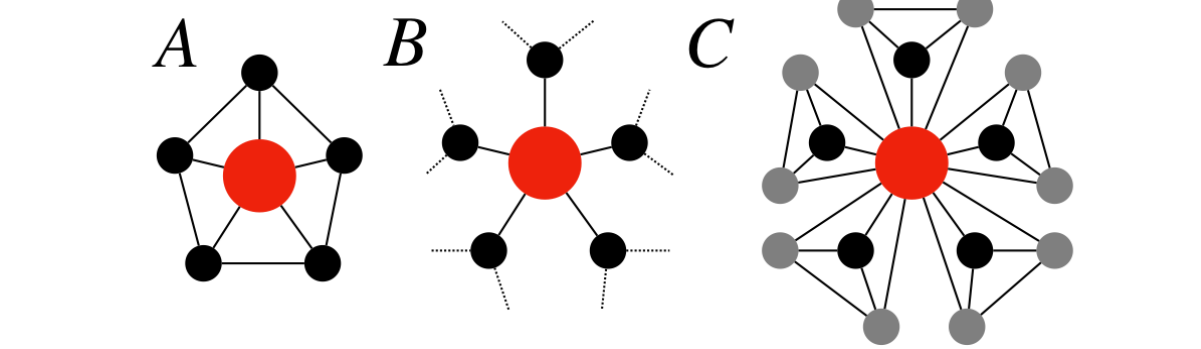
Figure 1. Three network structures associated with three distinct forms of social medical capital. The nodes represent the users, and each link refers to communication between users. The type of benefits that a focal user (the red node) can accrue from communication depends on whether the structure is: (A) closed, ie, the user’s partners also communicate with each other; (B) open, ie, the user acts as the intermediary between other users; or (C) mixed, ie, the user belongs to multiple densely connected groups and acts as the only intermediary between members of different